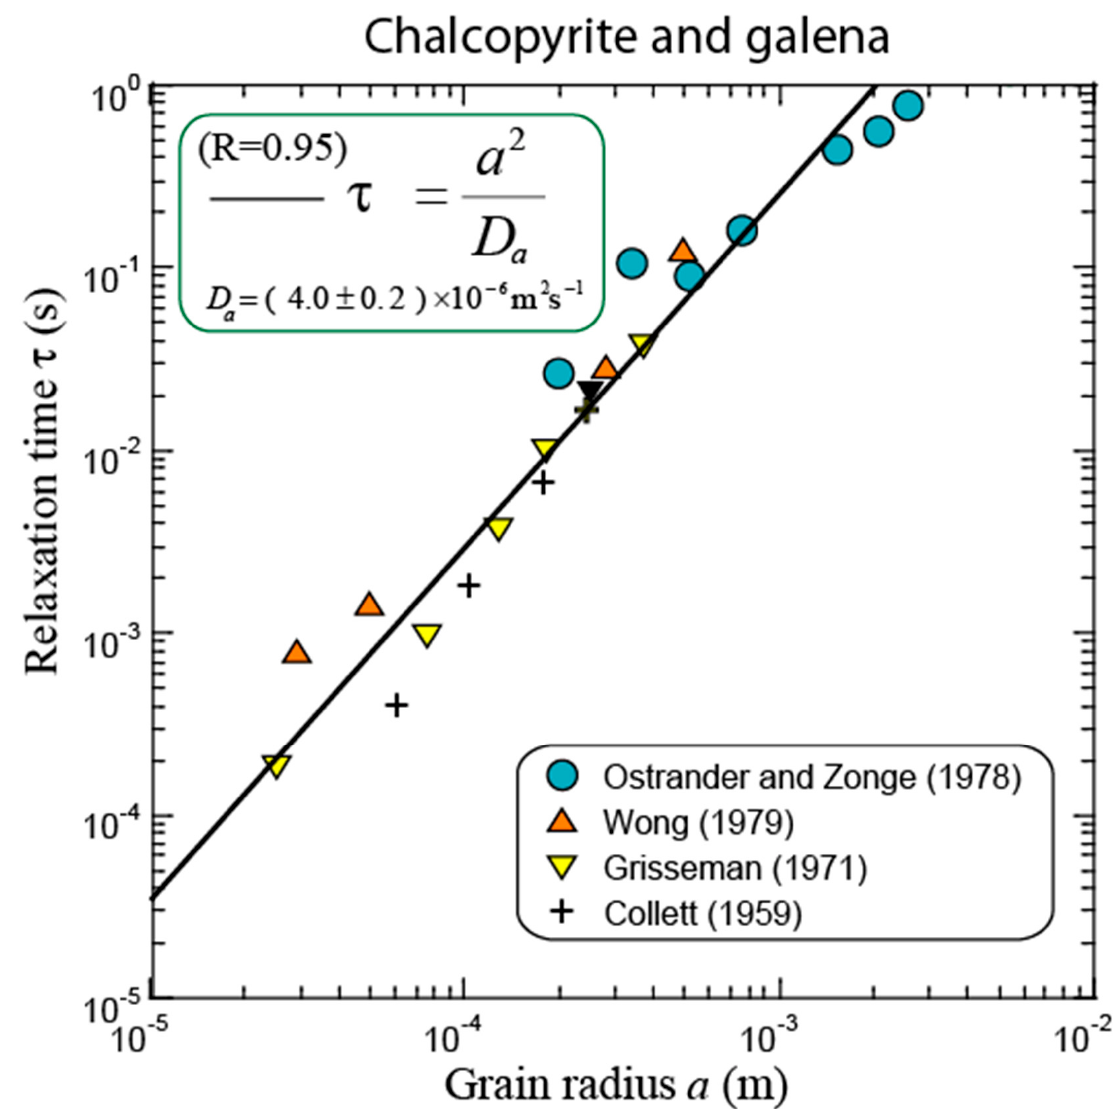
Figure 15. Time constant ( τ = 1/(2 π f peak )) for the complex conductivity model versus the radius of the metallic particles for chalcopyrite and galena. The quantity ( f peak ) denotes the critical frequency that corresponds to the maximum of the phase. Experimental data for chalcopyrite and galena: Ostrander and Zonge (1978) [90] (chalcopyrite); Wong (1979) [37] (chalcopyrite); Collett (1959) [92] (3% galena); Grisseman (1971) [93] (6.3% chalcopyrite). Background conductivity: σ b ~10 − 2 –10 − 3 S m − 1 . Modified from [47].